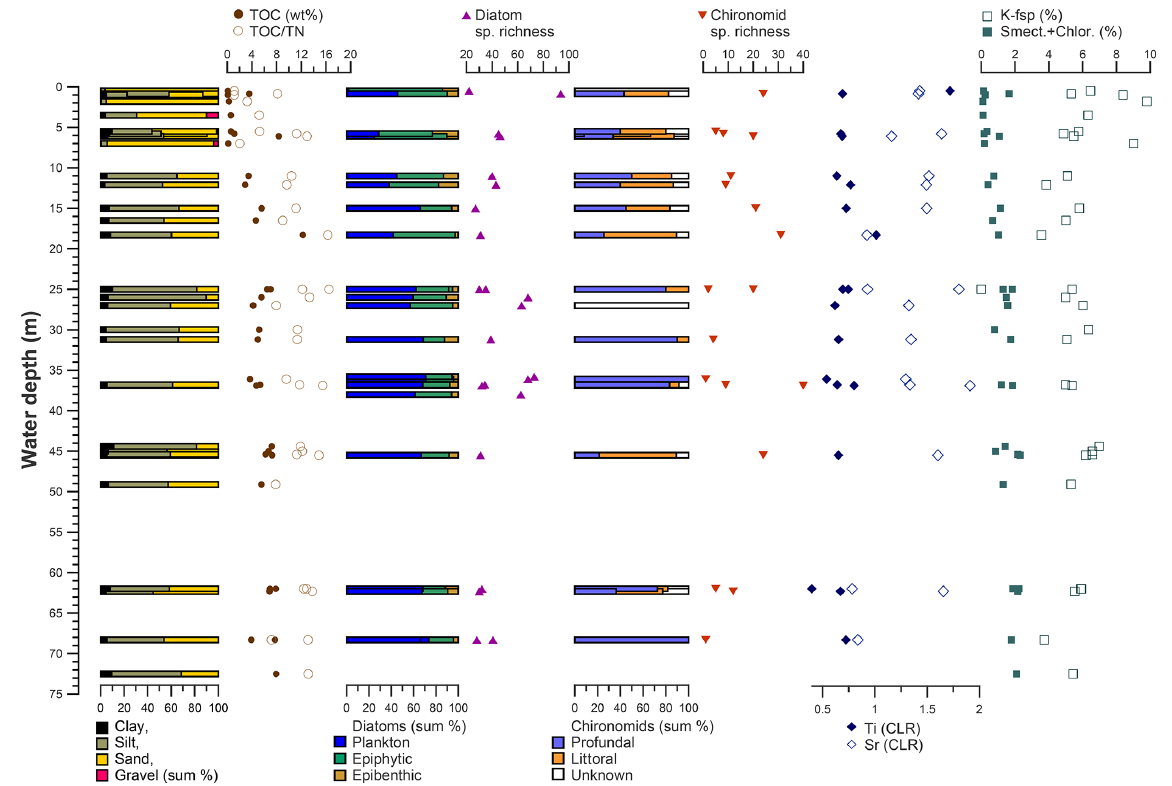
Figure 12. Distribution of grain size, organic carbon and nitrogen indices, diatom and chironomid parameters, and selected elements and minerals in dependence on water depth in Lake Bolshoe